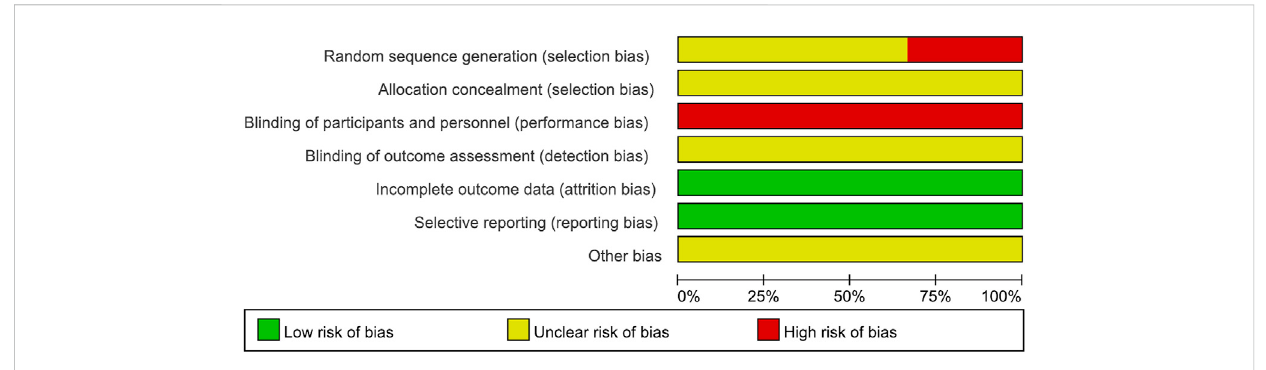
FIGURE 3 Graph showing the risk of bias across all included